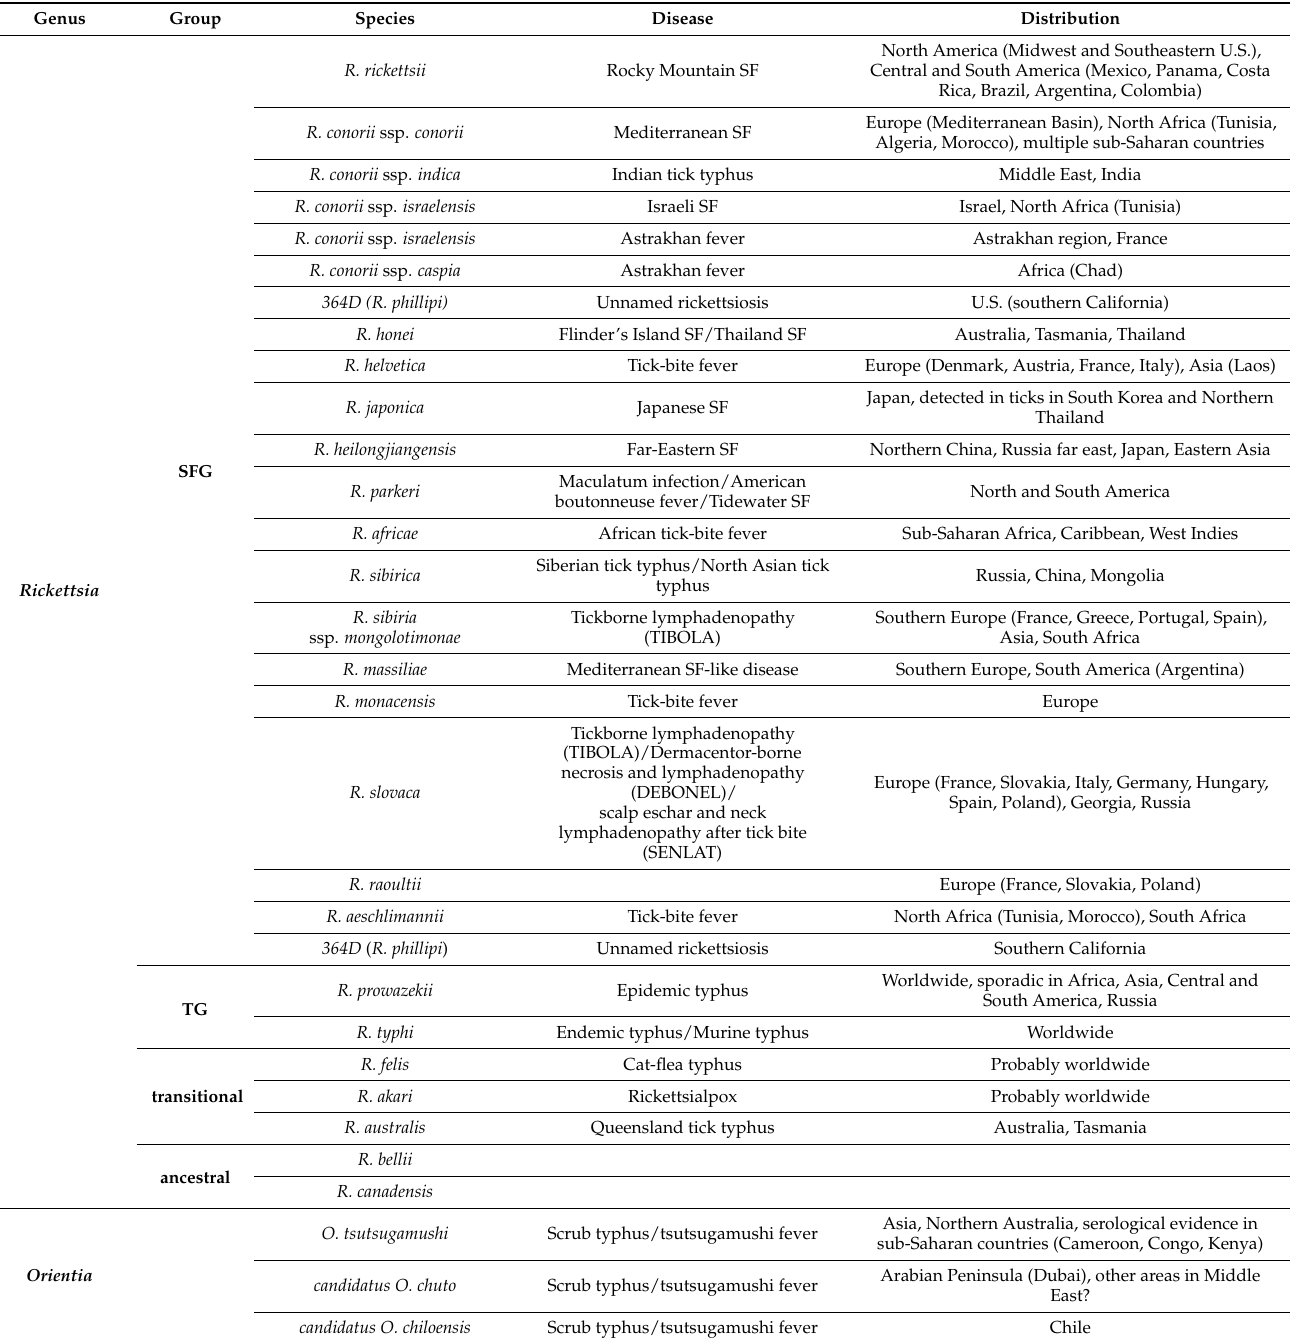
Table 1. Family of Rickettsiaceae , rickettsial diseases and distribution. The table gives an overview of so-far-identified members of the family of Rickettsiaceae. SFG: spotted fever group, TG: typhus group, SF: spotted fever. Genus Group Species Disease